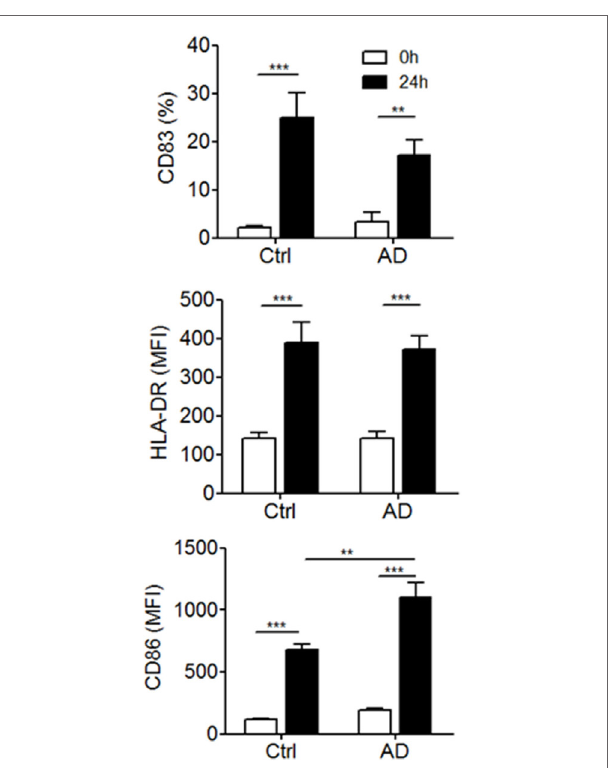
FigUre 3 | Expression of surface maturation markers by blood 6-sulfo LacNAc-expressing monocytes (slanMo) from healthy donors and atopic dermatitis patients. slanMo were stained within freshly isolated or 24-h cultured peripheral blood mononuclear cells and analyzed for the expression of HLA-DR, CD83, and CD86 by flow cytometry (Ctrl n = 10, AD n = 14). Statistical significance was calculated using a one-way ANOVA followed by Tukey’s posttest.